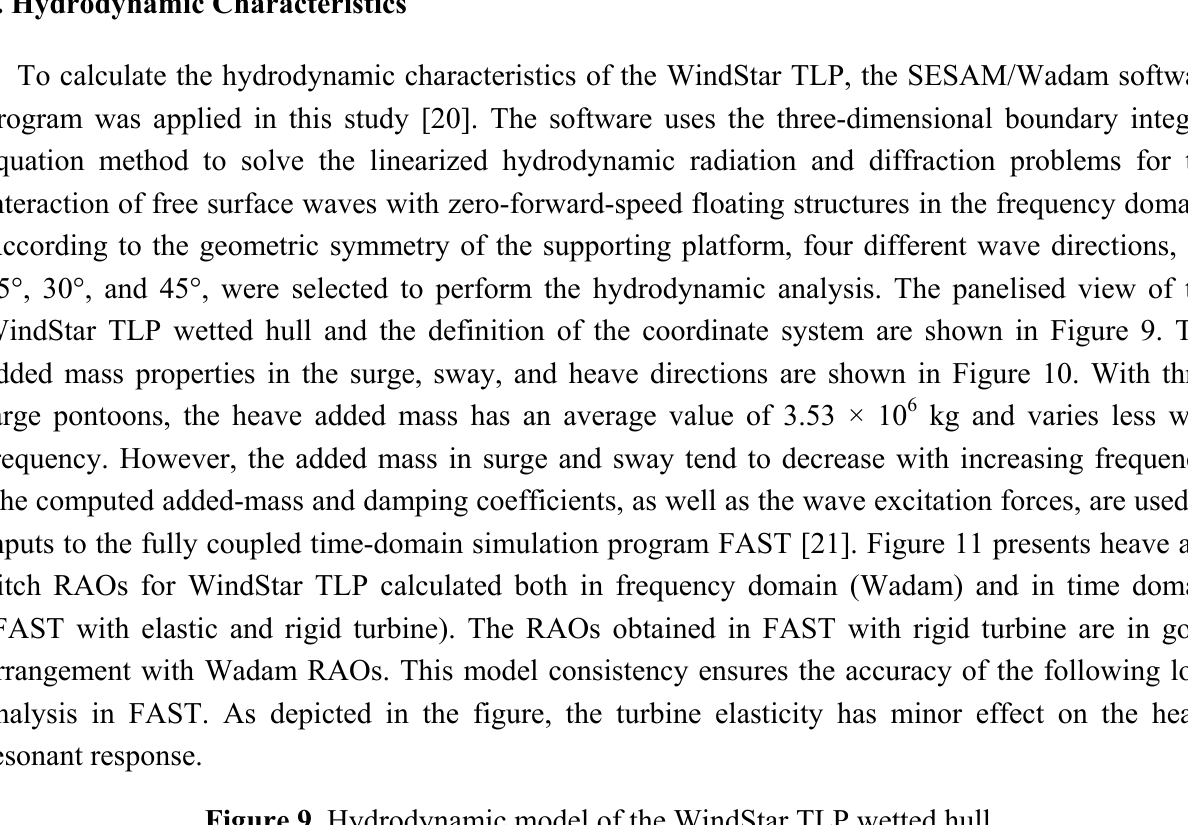
Figure 9. Hydrodynamic model of the WindStar TLP wetted